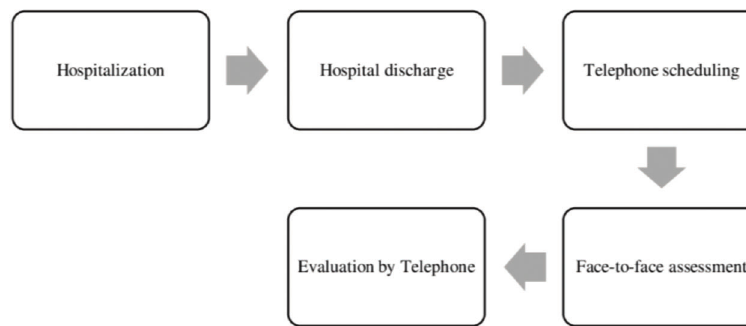
Figure 2 - Flowchart of the data collection